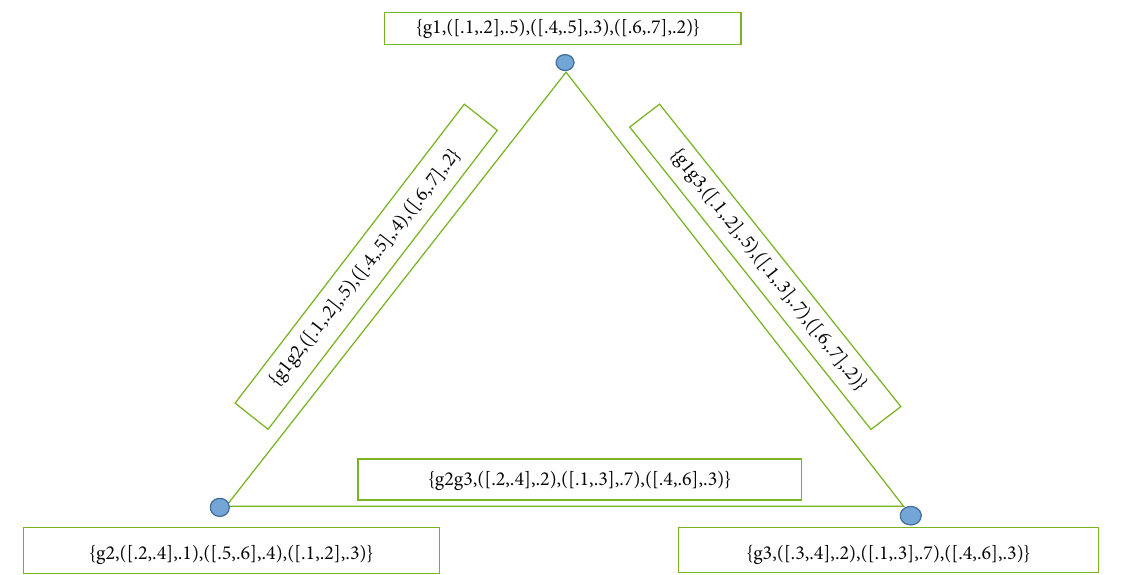
Figure 1: Represents a neutrosophic cubic